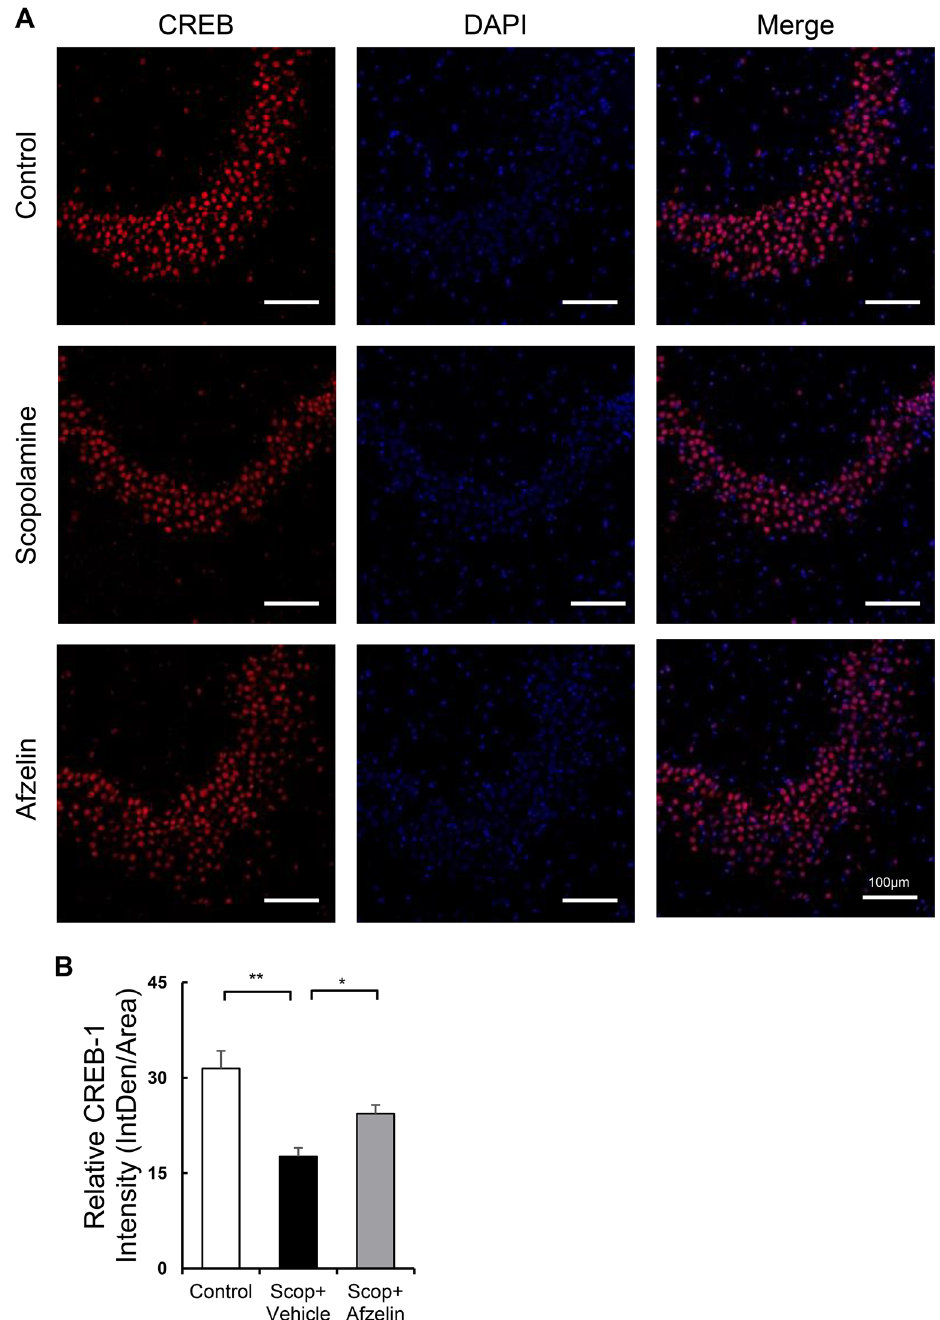
Figure 6. Immunofluorescence analysis of brain sections from the hippocampus. Standard C57BL/6 mice (4 weeks old) were pre-treated into third-ventricle of brains cannula with 100 ng/µl of Afzelin (0.5 µl) or PBS (0.5 µl) for one month. The mice were received with scopolamine (Scop) injection (i.p. 0.8 mg/kg) for the behavior tests then hippocampi of these mice were collected for immunofluorescence analysis. The representative images of immunoreactivity to CREB expression in the hippocampal CA3 region were shown with CREB (red) and DAPI (blue) using confocal microscopes ( A ). These images were quantified to bar graph in the control (PBS as a vehicle), scopolamine + vehicle (Scop + vehicle, PBS as a vehicle) and scopolamine + Afzelin (Scop + Afzelin, 100 ng/µl afzelin of pretreatments) groups ( B ). Scale bars, 100 μm. The fluorescence intensity was quantified using Image J. *p < 0.05 **p < 0.01; one-way ANOVA with Dunnett’s post hoc test; n = 3 for quantified bar graph ( B ). Data are mean ±